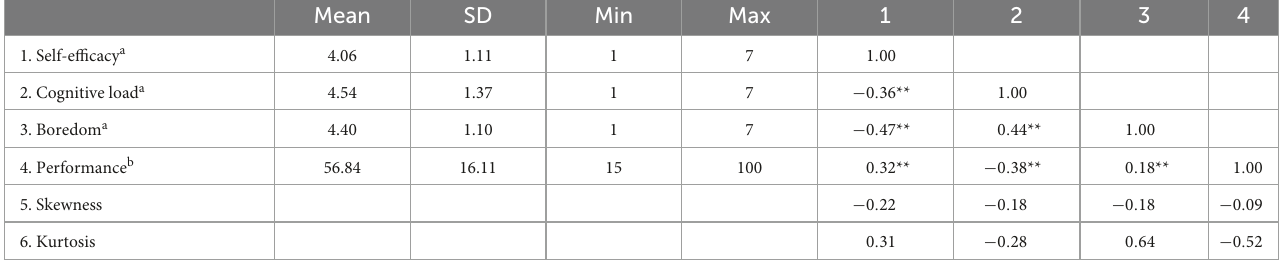
TABLE 2 Correlation of main variables.